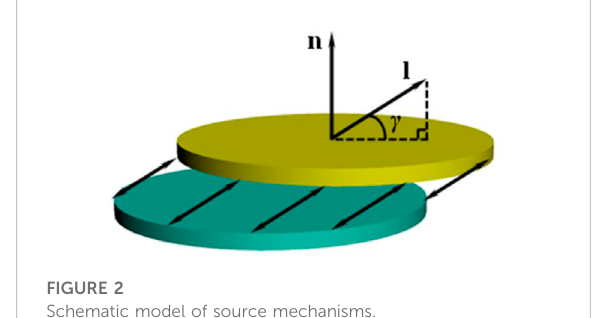
FIGURE 2 Schematic model of source